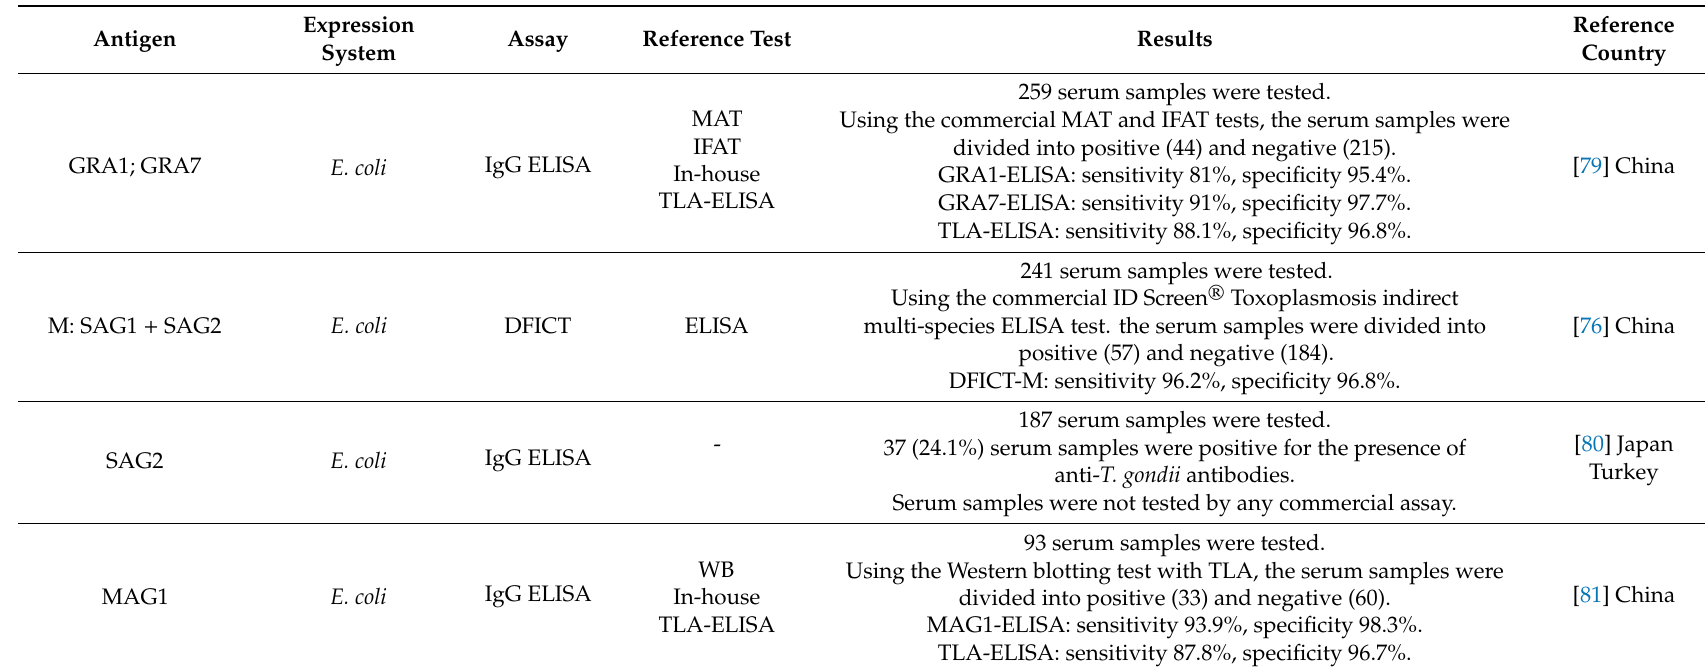
Table 3. Recombinant antigens used in detection of anti -T. gondii antibodies in canine serum